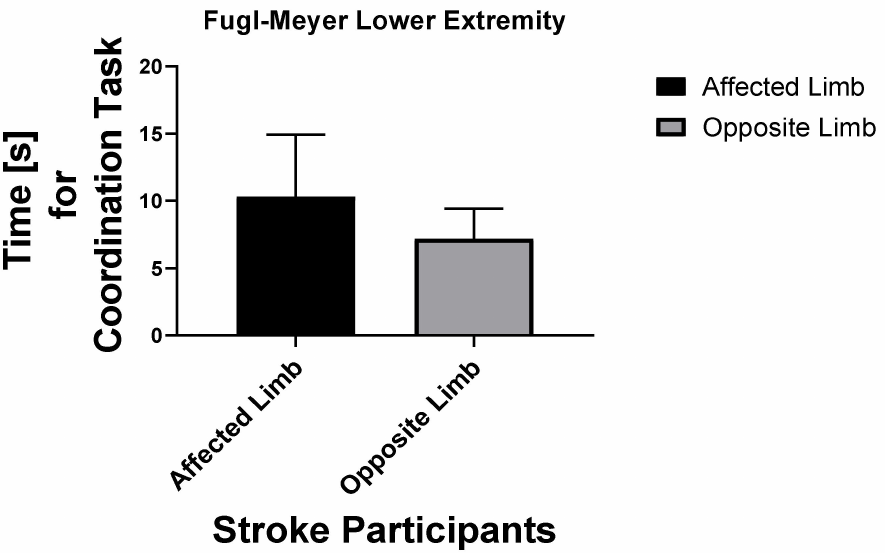
Figure 4. Time taken by affected and opposite foot for coordination task among stroke survivors during Fugl-Meyer